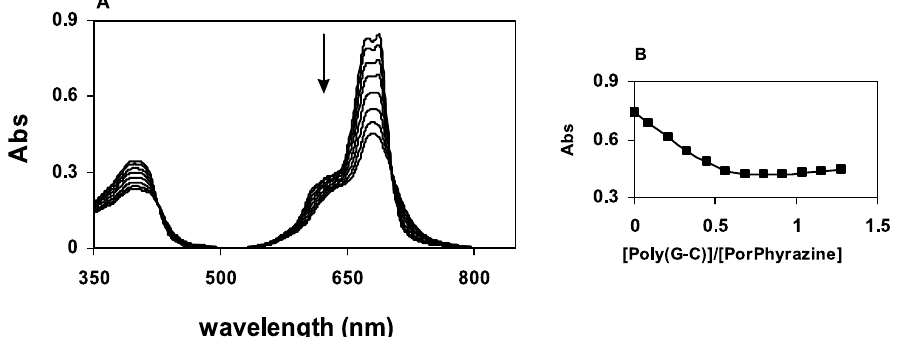
Fig. 1. (A): Absorption spectra of Zn (tmtppa) (14 . 5 (cid:1) M) in the presence of poly (G-C): 0, 0.16, 0.32, 0.48, 0.63, 0.78, 0.94, 1 . 09 (cid:1) M. The arrow indicates the absorbance changes with increasing [poly (G-C)]. (B) The variation of absorbance at the Q-band (688nm) versus mole ratio of poly (G-C) to Zn (tmtppa).